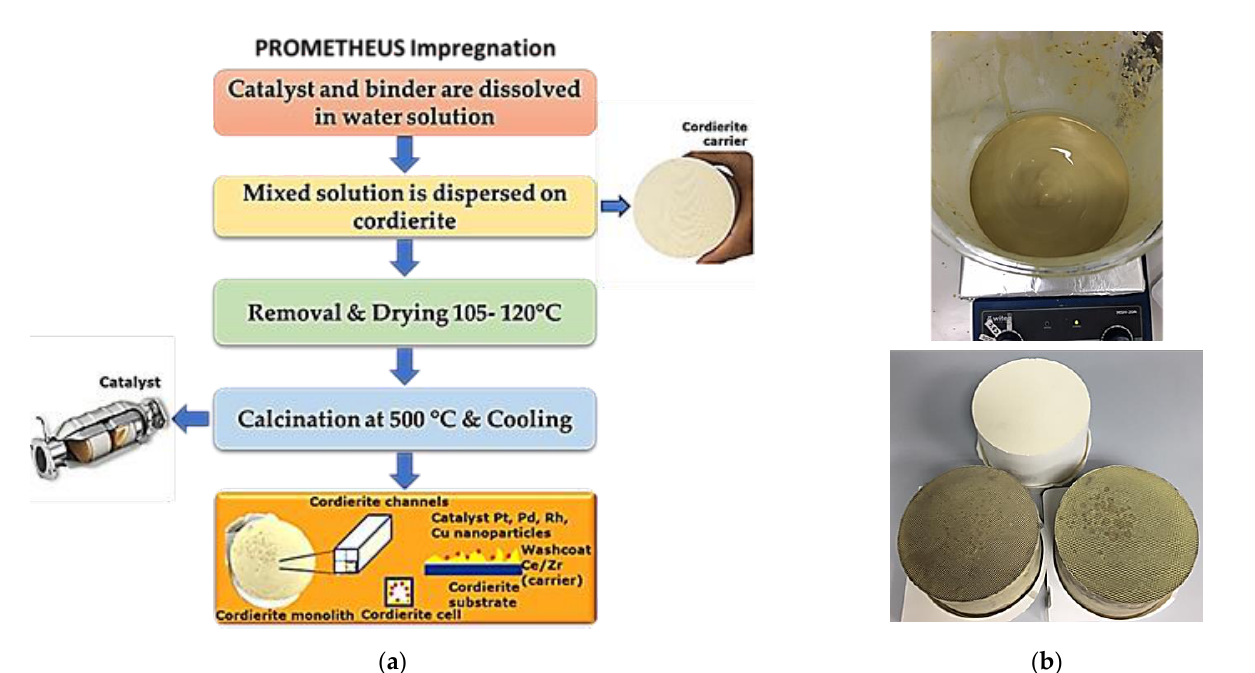
Figure 5. ( a ) Flow chart Prometheus impregnation; ( b ) aqueous slurry preparation and ceramic monolith before and after the impregnation into the aqueous slurry.